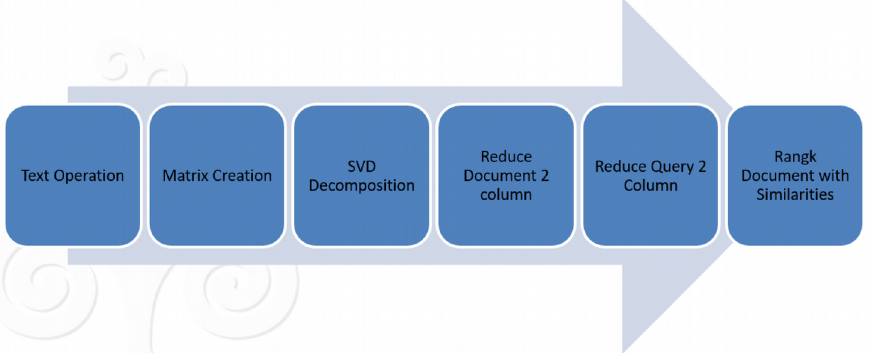
Figure 5. Step method